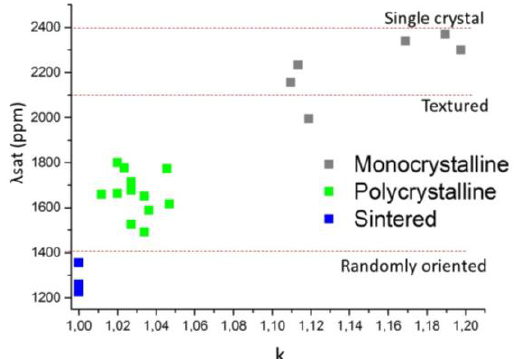
Figure 4. Dependence of the saturation magnetostriction λsat with the magnetic anisotropy ratio k for monocrystalline, polycrystalline and sintered